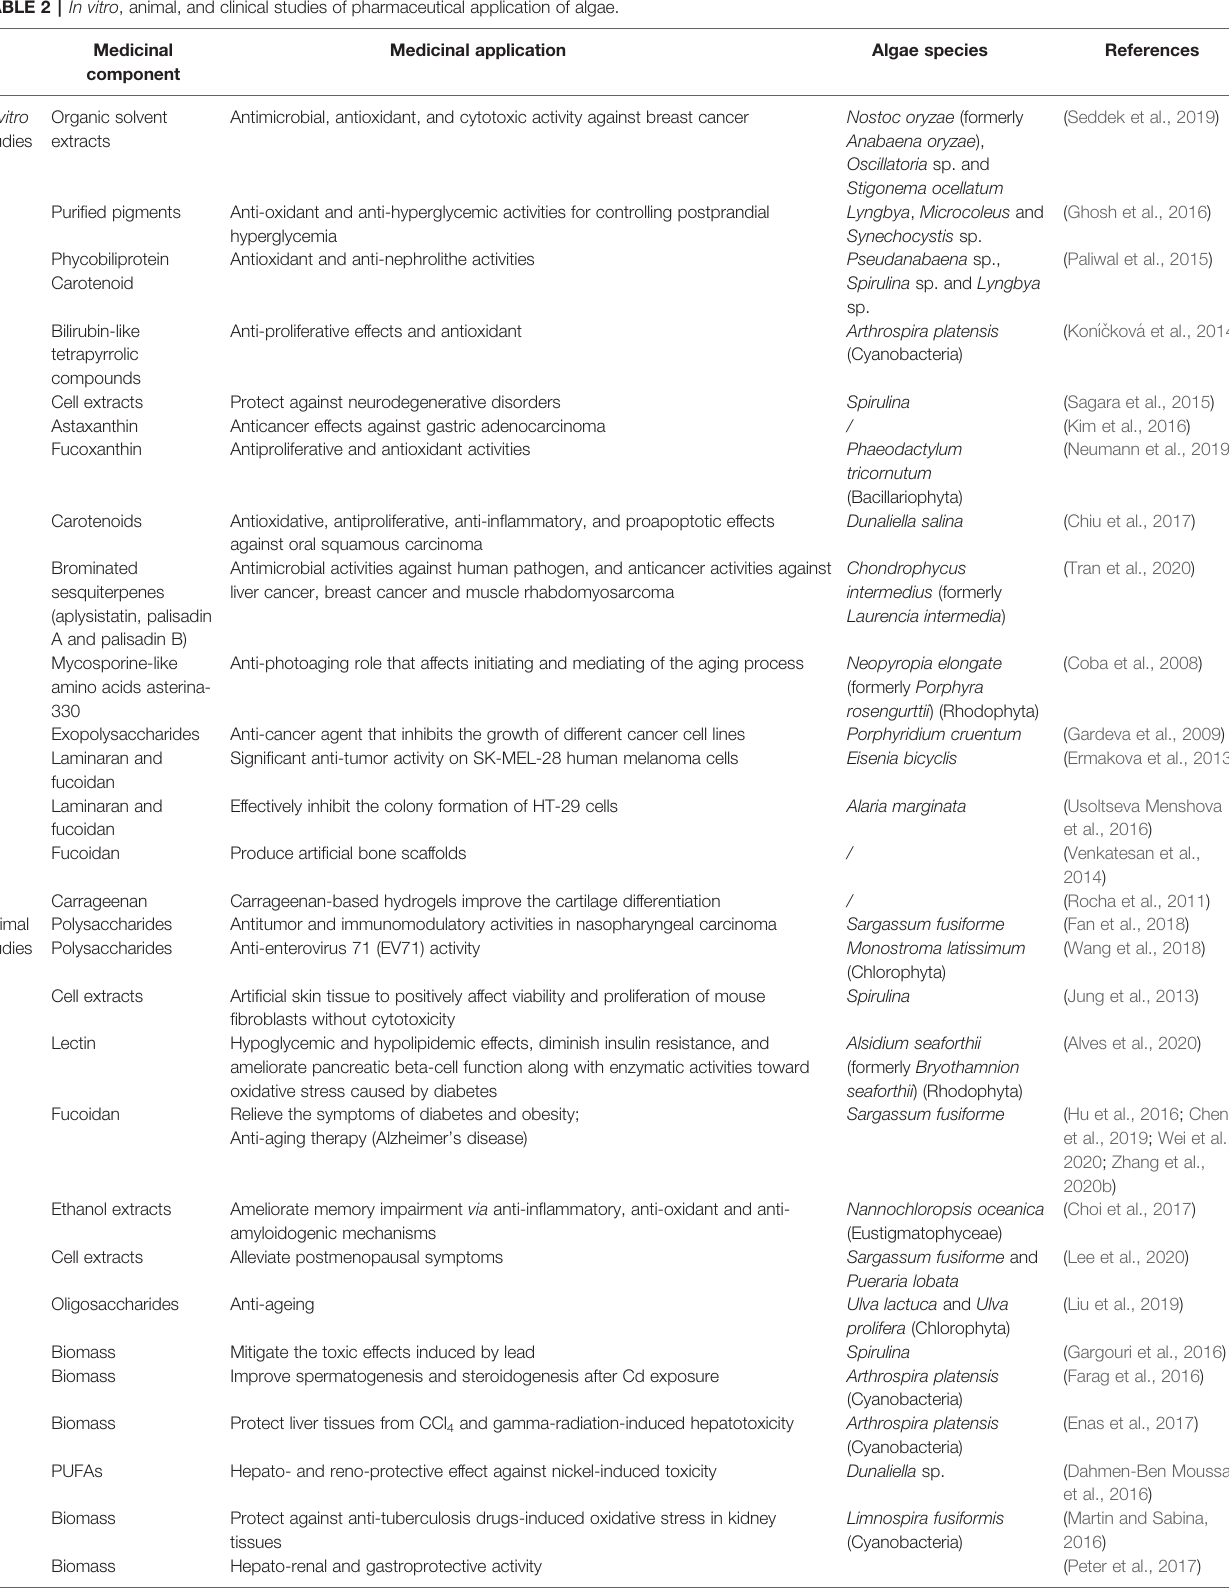
TABLE 2 | In vitro , animal, and clinical studies of pharmaceutical application of